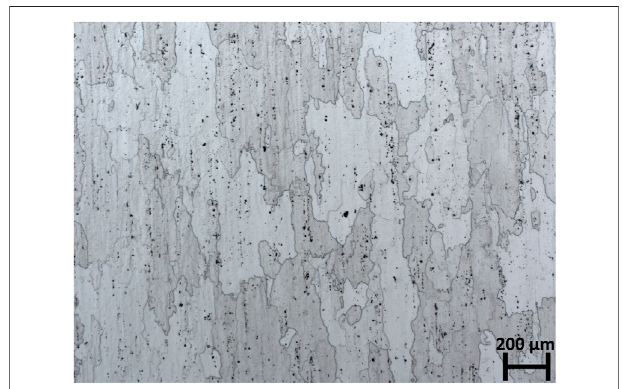
FIGURE 2 | Optical micrograph of the Al 7075 T651 plate. The representative average grain size is 135 ± 70 µm estimated by line intercept method.